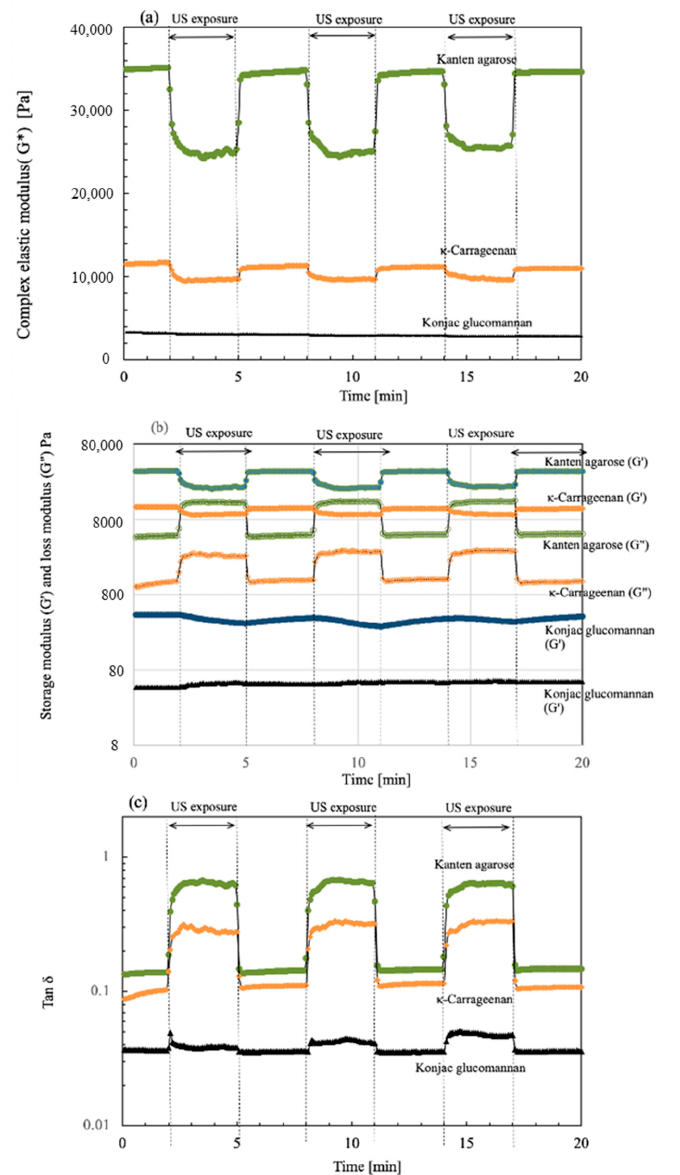
Figure 1. Time course of ( a ) complex modulus G*, ( b ) storage (G ′ ) and loss modulus (G ″ ), and ( c ) tan δ for each hydrogel in the absence and presence of US exposure at 3 min cycled intervals.